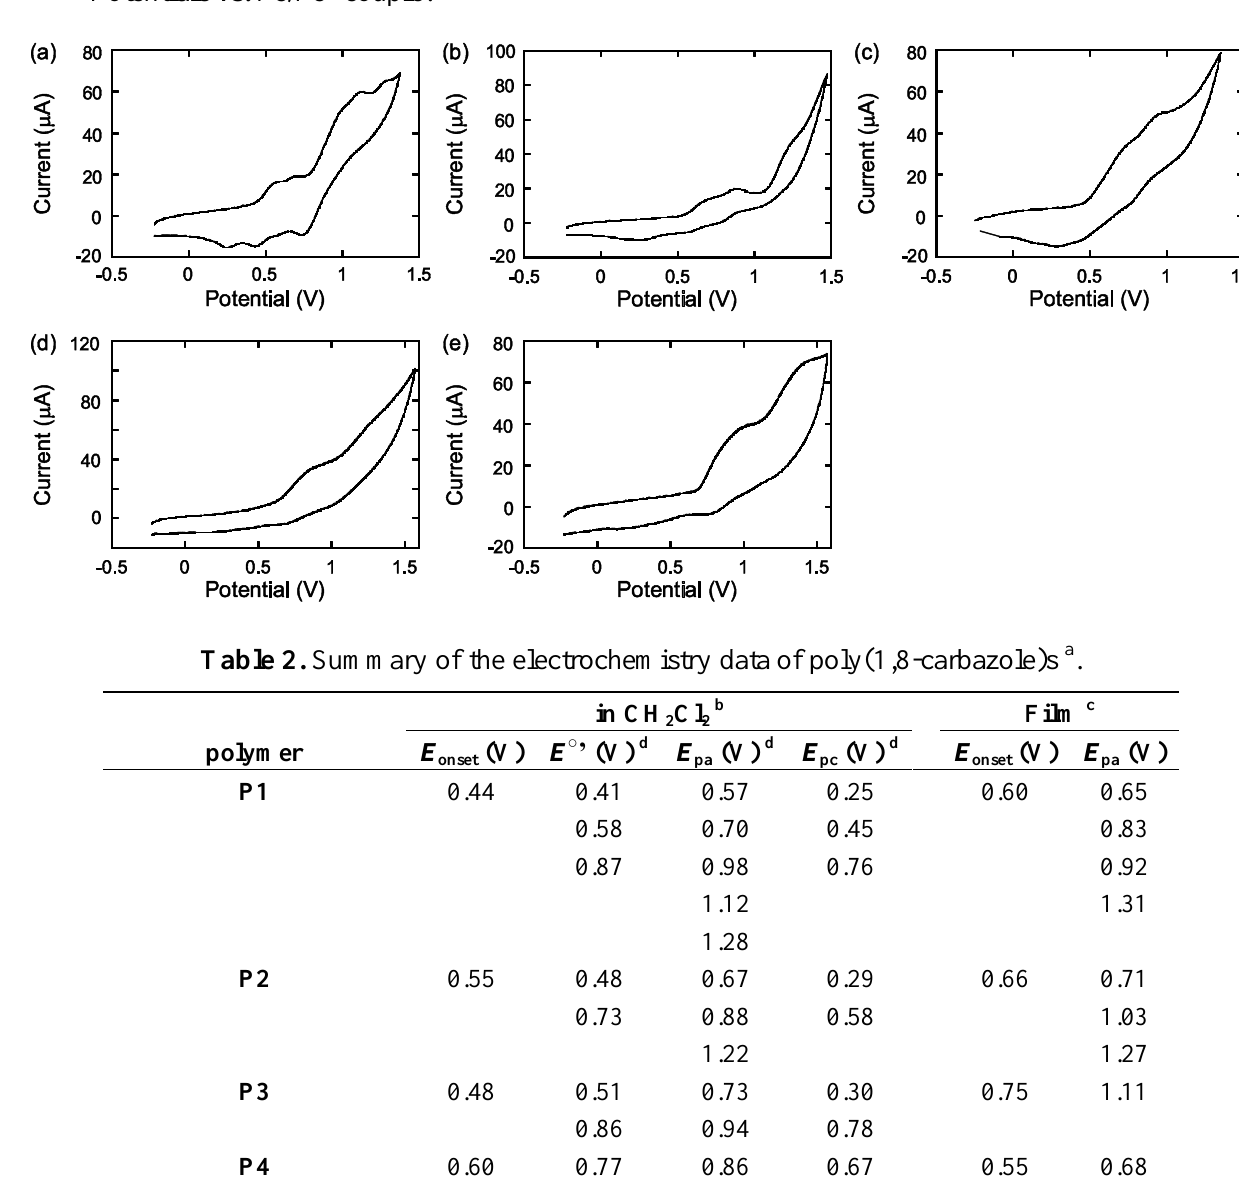
H ) NClO at the scanning rate of 0.1 V s −1 under flowing nitrogen. 4 9 4 4